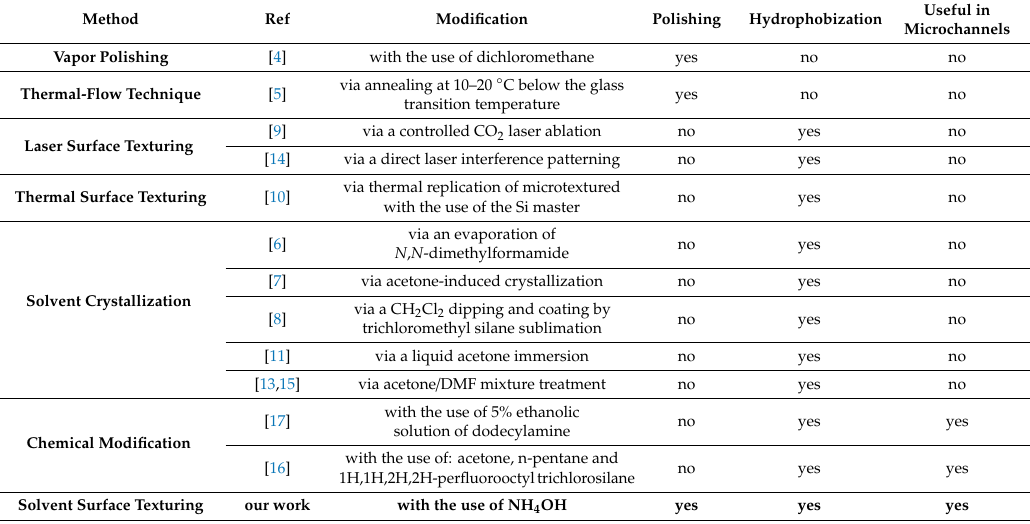
Table 1. Comparison of the polishing and hydrophobization methods of polycarbonate surface.